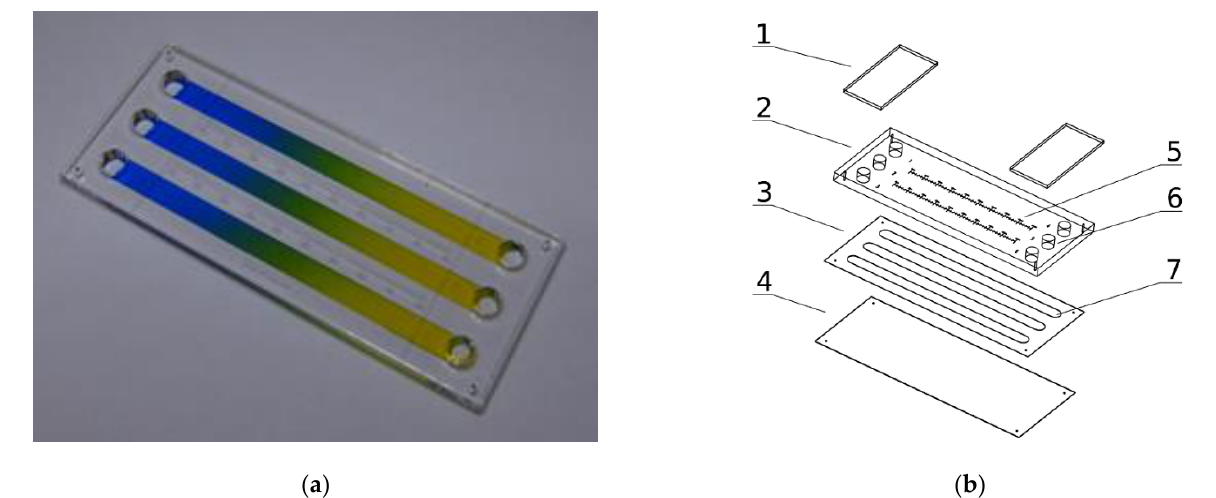
Figure 1. Microsystem for cell cultures in molecular gradients: ( a ) Photograph of a device with established gradients; ( b ) Exploded view of microsystem layers: 1—covers of media reservoirs, 2—polymethyl methacrylate layer, 3—adhesive film layer, 4—polycarbonate layer, 5—millimeter graduation, 6–media reservoirs, 7—culture chambers.